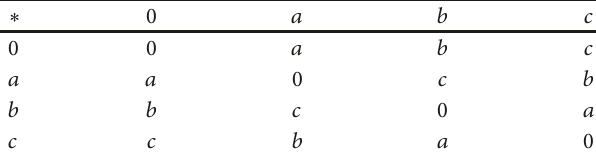
Table 1: Cayley table for the binary operation “ ∗